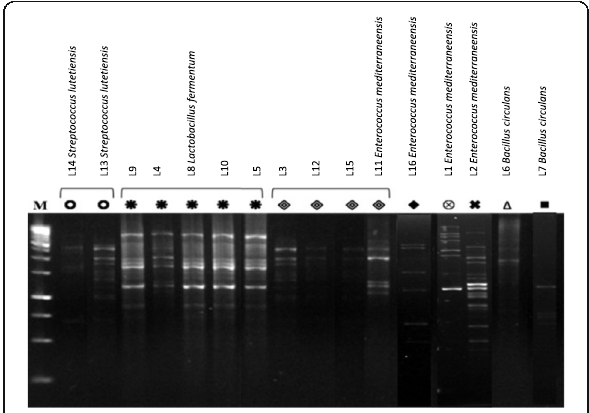
Fig. 1 BOX-PCR fingerprints of 16 bacterial isolates. Fingerprint profiles labeled with the same symbol are identical. M, 1 Kb